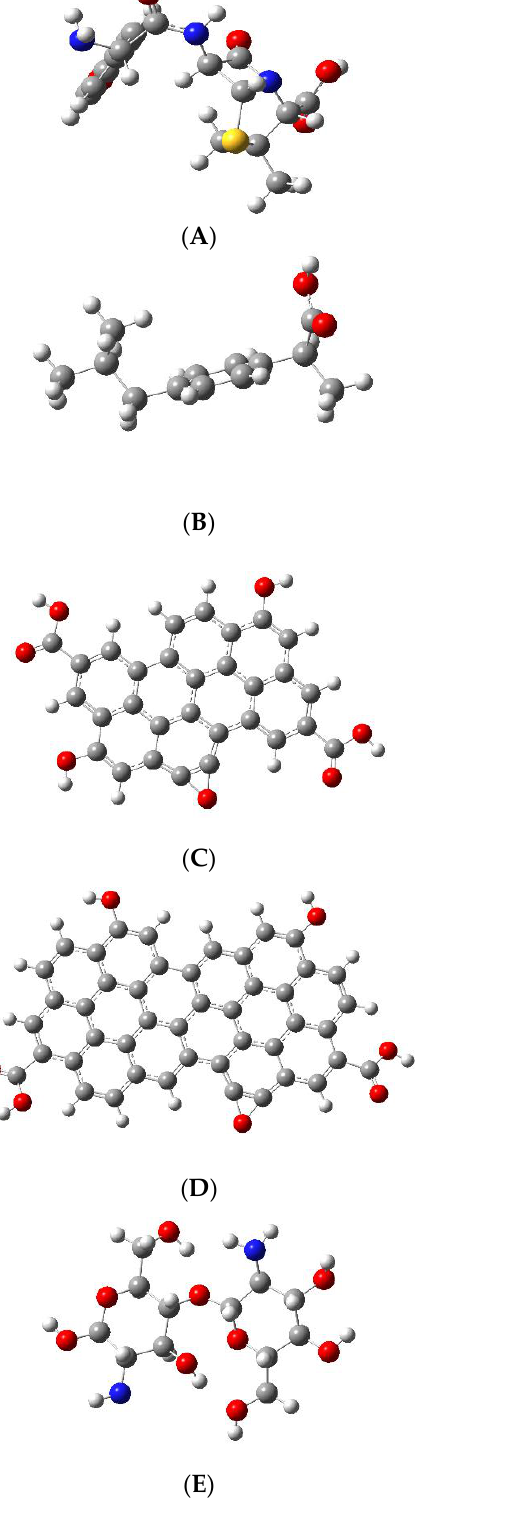
Figure 1. Left: minimum energy structures at ωB97X-D/6-311G(2d,p) level of theory. ( A ) amoxicillin; ( B ) ibuprofen; ( C ) graphene oxide (pyrene, GO-1); ( D ) graphene oxide (coronene, GO-2); and ( E ) chitosan. On the right, electrostatic potential (ESP) surface; scale in kcal/mol.